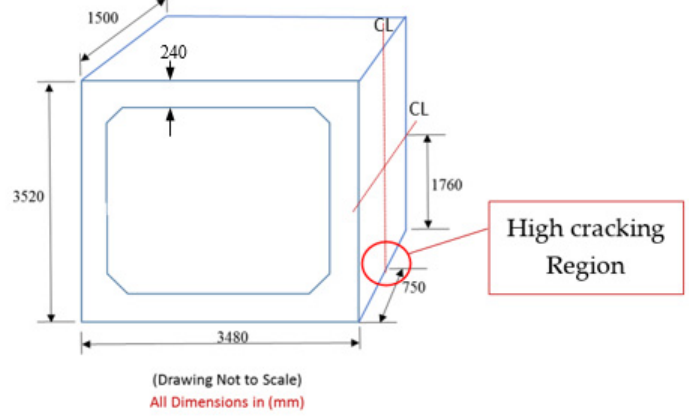
Figure 11. Precast model indicating the cracking region.